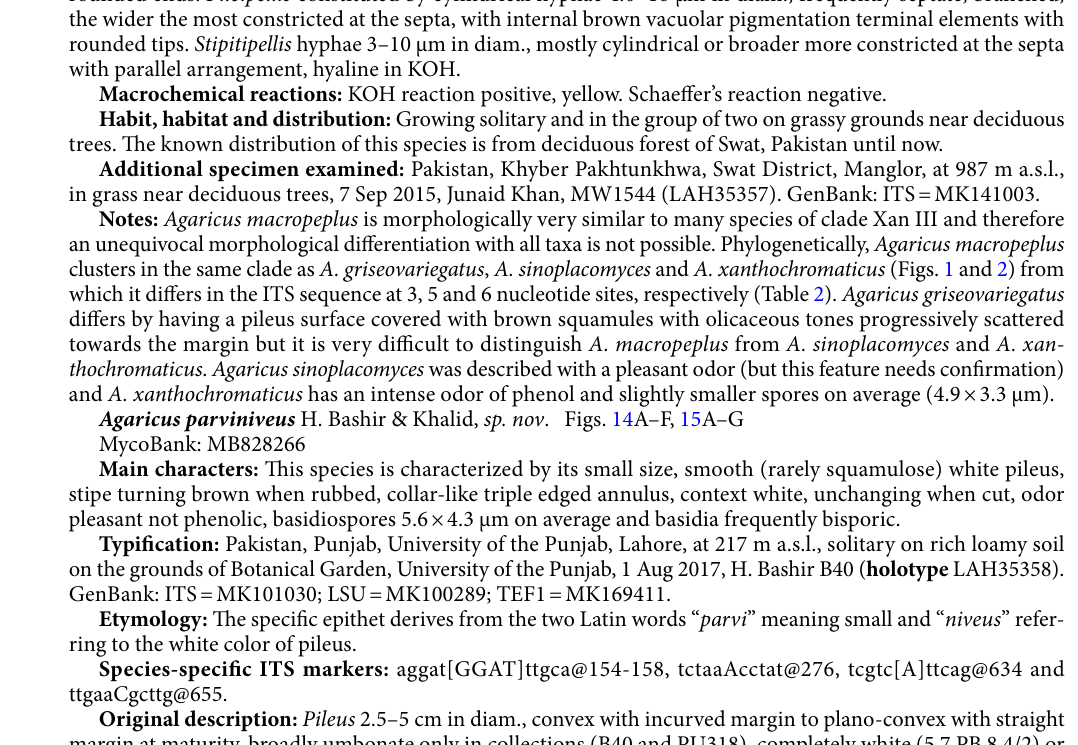
ring to the white color of pileus. Species-specific ITS markers: aggat[GGAT]ttgca@154-158, tctaaAcctat@276, tcgtc[A]ttcag@634 and ttgaaCgcttg@655. Original description: Pileus 2.5–5 cm in diam., convex with incurved margin to plano-convex with straight margin at maturity, broadly umbonate only in collections (B40 and PU318), completely white (5.7 PB 8.4/2) or